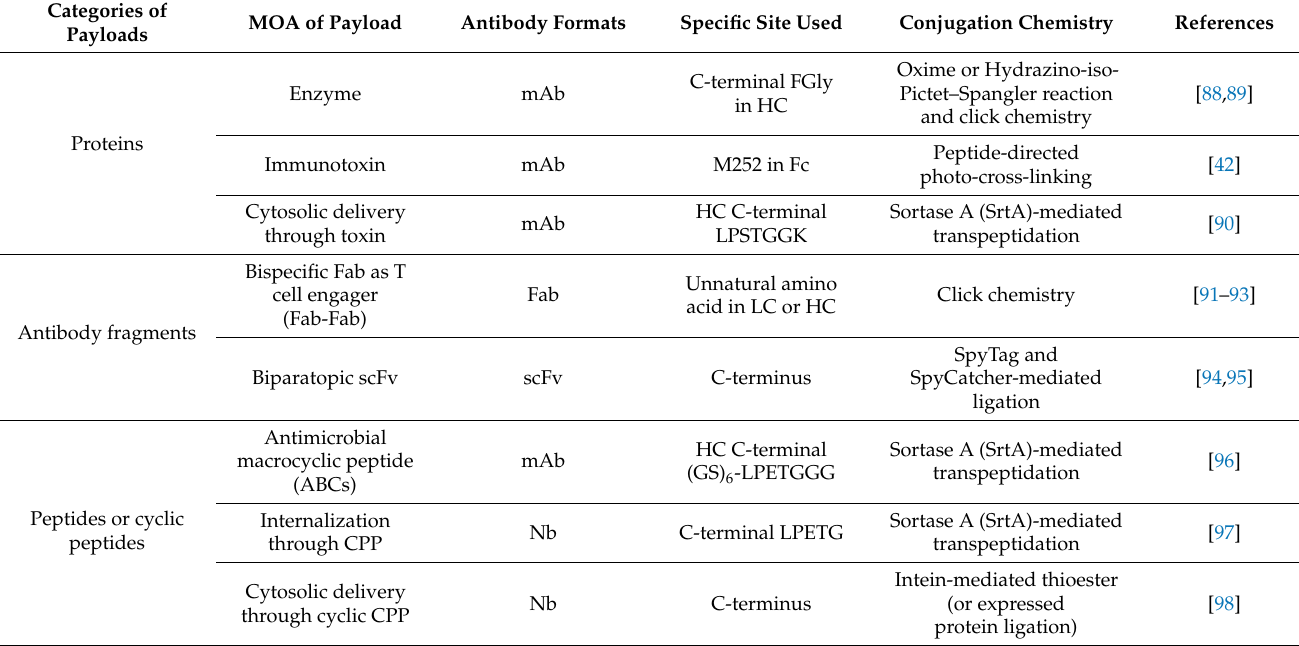
Table 3. Site-specific antibody conjugation with proteins and